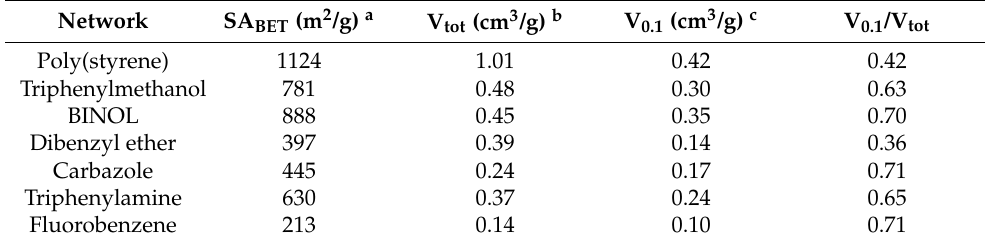
Figure 3. Full gas sorption isotherms for all polymer networks synthesized. Poly(styrene), triphe- nylmethanol, BINOL, carbazole, triphenylamine, dibenzyl ether and fluorobenzene. Table 1. Gas sorption properties of HCP